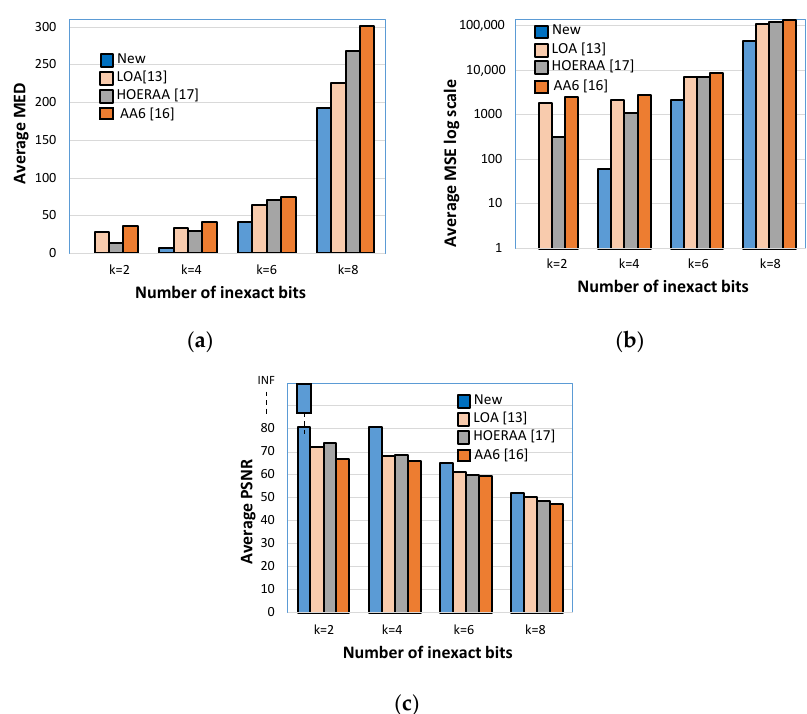
Figure 10. Accuracy results obtained for the Cameraman benchmark in terms of: ( a ) MED; ( b ) MSE; ( c ) PSNR.